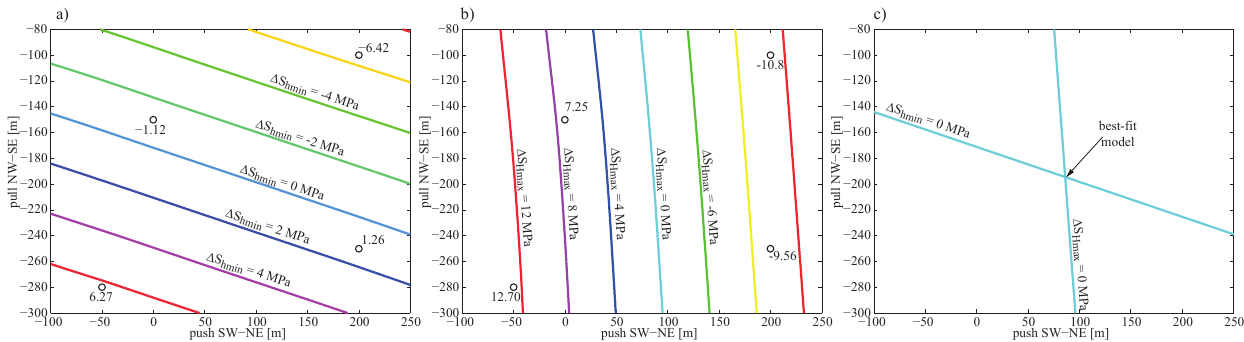
Figure 15. Plot of four models with different shortening or extension at the model boundary; see Table 2 for details. (a) and (b) : the median S hmin and the median S Hmax are plotted depending on the northwest to southeast extension (pull) and the southwest to northeast shortening (push). The isolines of the median (cid:49)S hmin and (cid:49)S Hmax are colour coded. (c) The isolines where the median (cid:49)S hmin and (cid:49)S Hmax are zero are plotted alone. The intersection of both isolines indicated the push-pull values where the best-fit model can be found.